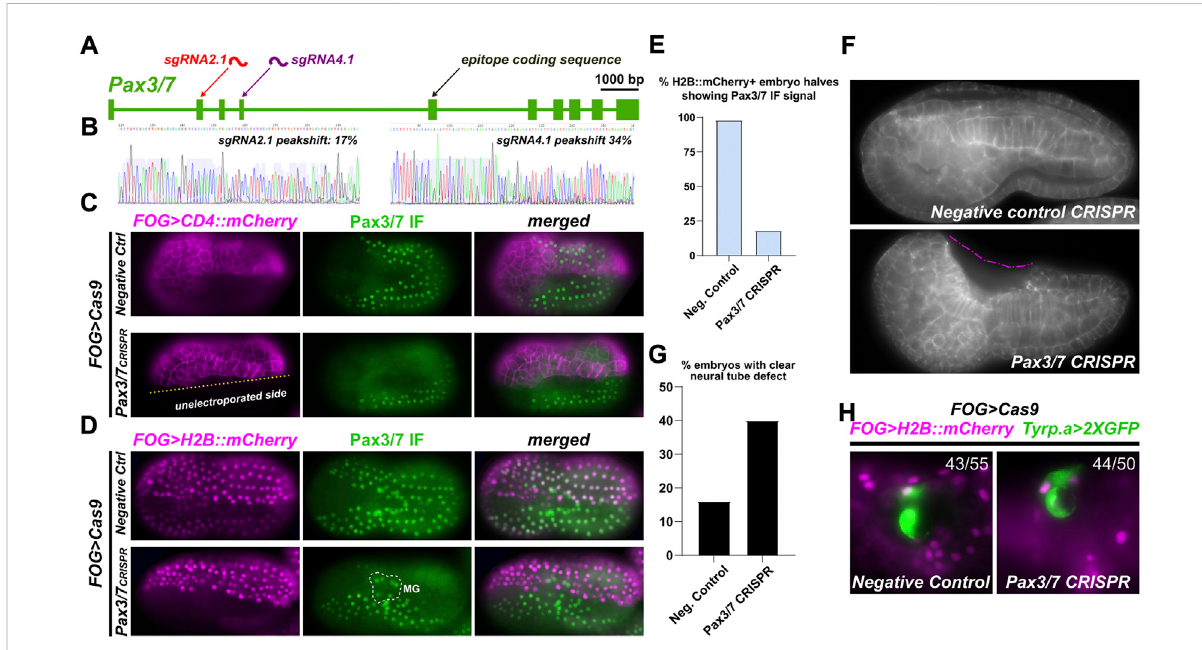
FIGURE 3 Pax3/7 CRISPR in the neural plate borders. (A) Diagram of Pax3/7 locus and location of sgRNA targets, relative to epitope sequence recognized by DP312 antbody. (B) Peakshift sequencing traces indicating presence of indels resulting from CRISPR/Cas9-mediated double-stranded DNA breaks. (C) Tissue-speci fi c CRISPR/Cas9-mediated knockout of Pax3/7, performed in a/b-line cells using the FOG > Cas9 plasmid and assayed by DP312 immuno fl uorescence at stage 16. FOG > CD4::mCherry counterstains cell membranes, demonstrating the speci fi city and ef fi cacy of Pax3/7 knockout. (D) Pax3/7 CRISPR and negative control embryos generated as above (same stage also), but using FOG > H2B::mCherry to score proportionofCRISPRknockouts.MotorGanglion(MG)cellsarenotderivedfroma/blineages,andthereforeCas9isneverexpressedintheirlineage. Thus, Pax3/7 signal is not lost from the MG, only NPBs. (E) Embryos scored for loss of Pax3/7 immuno fl uorescent signal (from panel d), showing substantiallossofstainingin Pax3/7 CRISPRH2B::mCherry+NPBcells(n=40embryohalves)comparedtonegativecontrol(n=43halves). (F) Pax3/ 7 CRISPR and negative control (U6 > DenhT2) embryos stained with fl uorescent phalloidin conjugate to reveal cell outlines after neural tube closure, at stage 20. Dashed pink line denotes a large cavity as a result of failed neural tube closure. (G) Embryos above were scored for incomplete neural tube closure defect (n = 100 embryos each condition). Embryos with inconclusive neural tube closure phenotype were not scored as defective. (H) Pax3/7 CRISPRdoesnotaffectthespeci fi cationofneuralplateborder-derivedpigmentcells.RatiosindicatenumberofFOG >